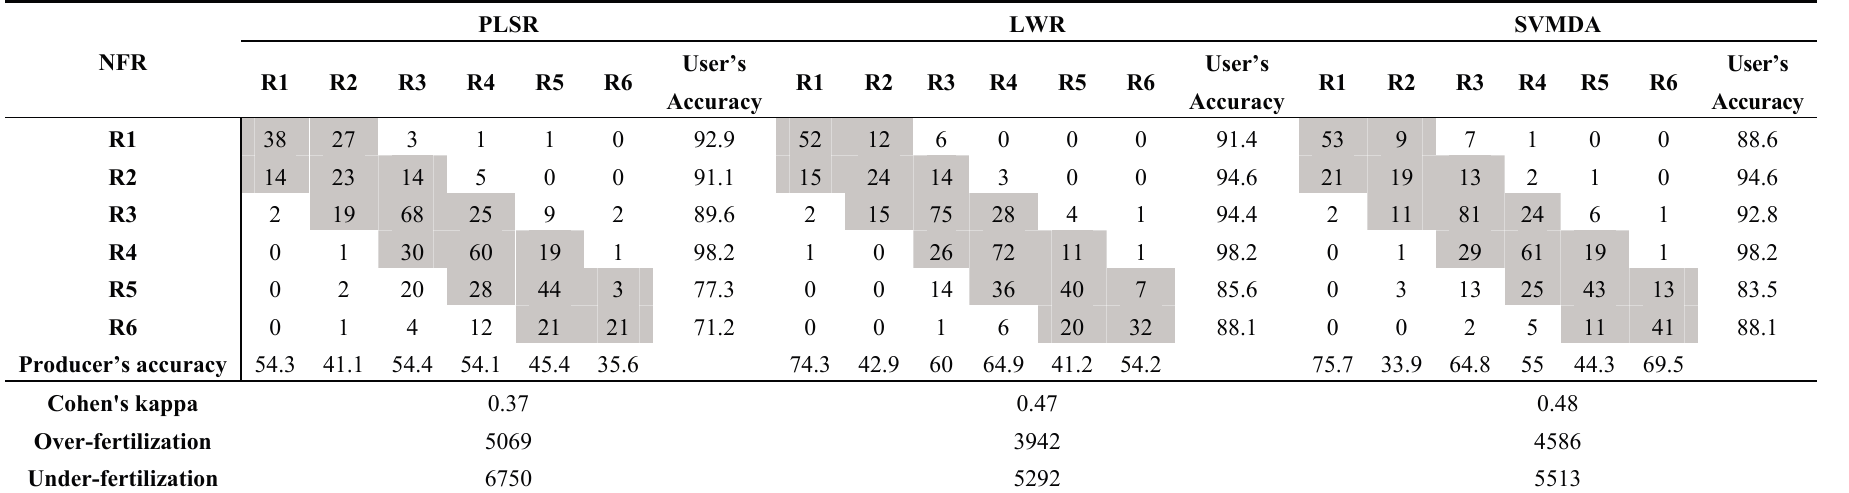
Table 3. The accuracy of three rating methods depicted in a confusion matrix using six training rates from all 518 samples associated with nitrogen over-fertilization (kg) and under-fertilization